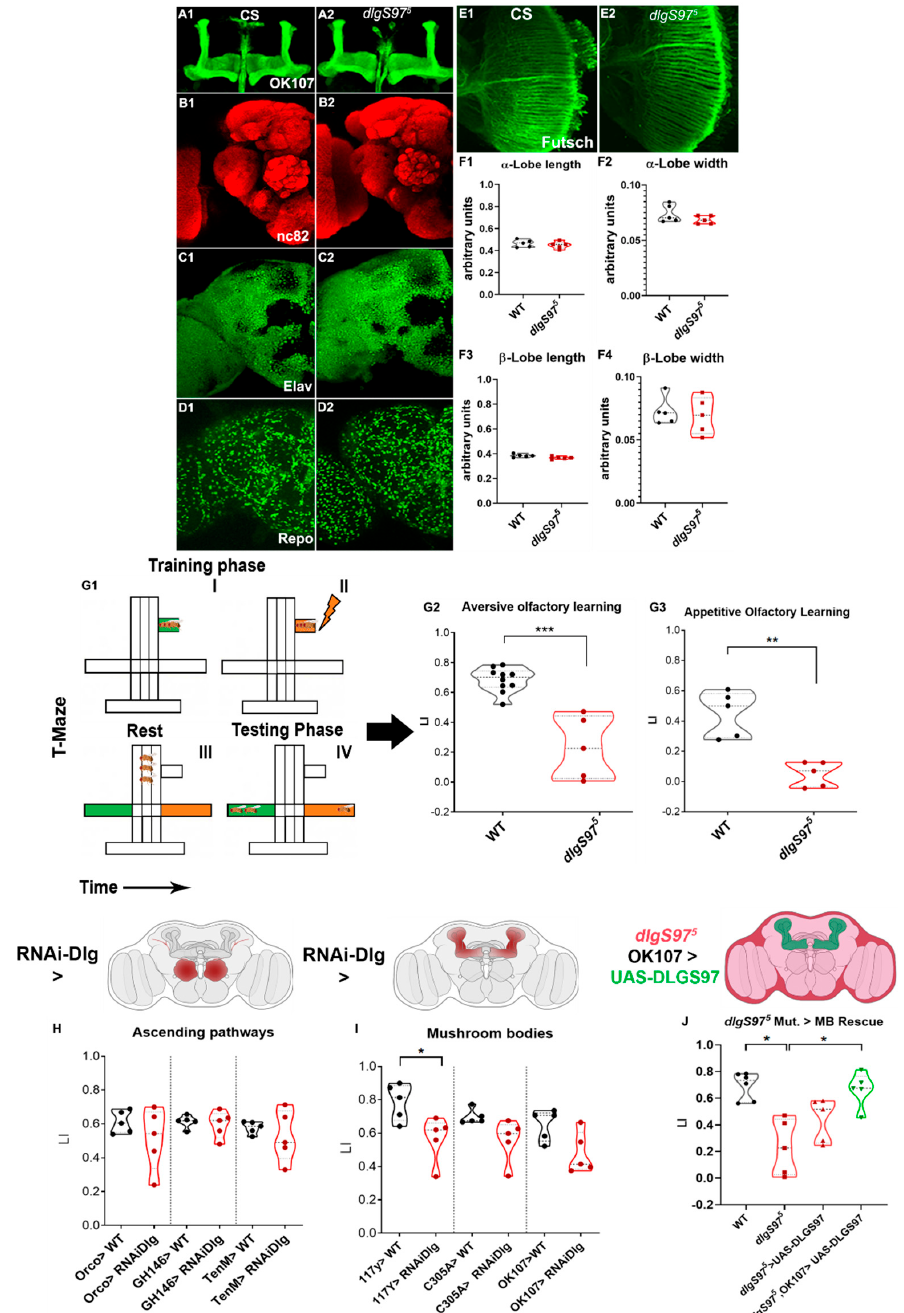
Figure 2. DlgS97 is necessary in the mushroom bodies, but not required in the ascending olfactory pathway for associative olfactory learning. ( A1 – F4 ) Expression of CNS markers in dlgS97 5 mutants in adult brains; Immunofluorescence of adult control ( A1 – E1 ) and dlgS97 5 ( A2 – E2 ) mutant brains; ( A ) brains expressing CD8–GFP with the OK107 promoter expressing in all Kenyon cells to study the structure of the MB neuropile; ( B ) brains labeled with an antibody against the active zone protein bruchpilot (nc82 antibody) to observe the general structure of the brain; ( C ) Brains labeled with the antibodies against the neuronal-specific protein Elav; ( D ) Brains labeled with the antibodies against the glial-specific protein Repo ( E ) optic lobes labeled with the antibody Futsch against the cytoskeleton protein MAP to observe the axonal connectivity. Mutant brains show mushroom bodies ( A ) antennal lobe and optic lobe normal structure as well as the general neuronal and glial density; ( F1 – F4 ) Measurements of different parameters of the MB in control and mutant brains. No significant